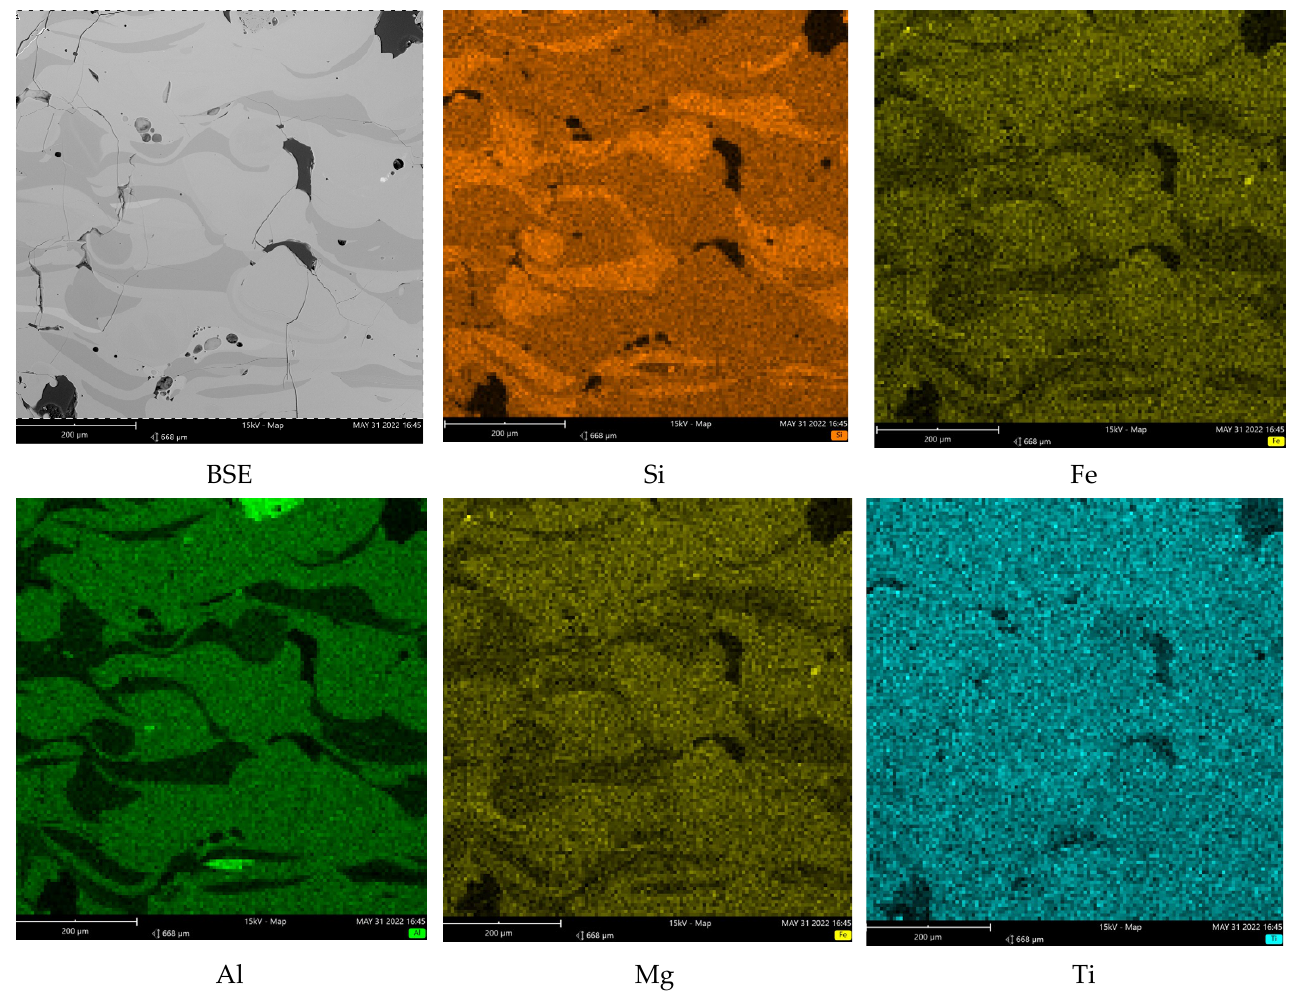
Figure 6. Element mapping of the sample Mong470, polished cross section.